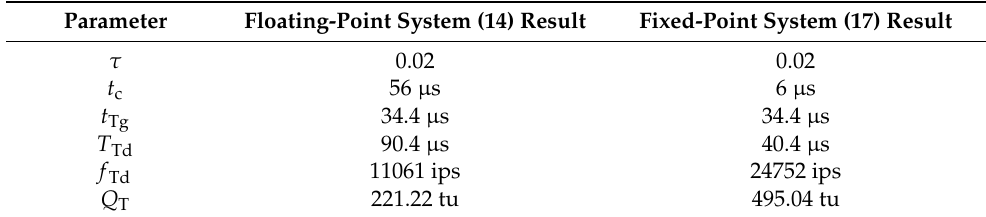
Table 6. Implementation results of the DV of NHS system (14) versus DV of system NHS (17) on the